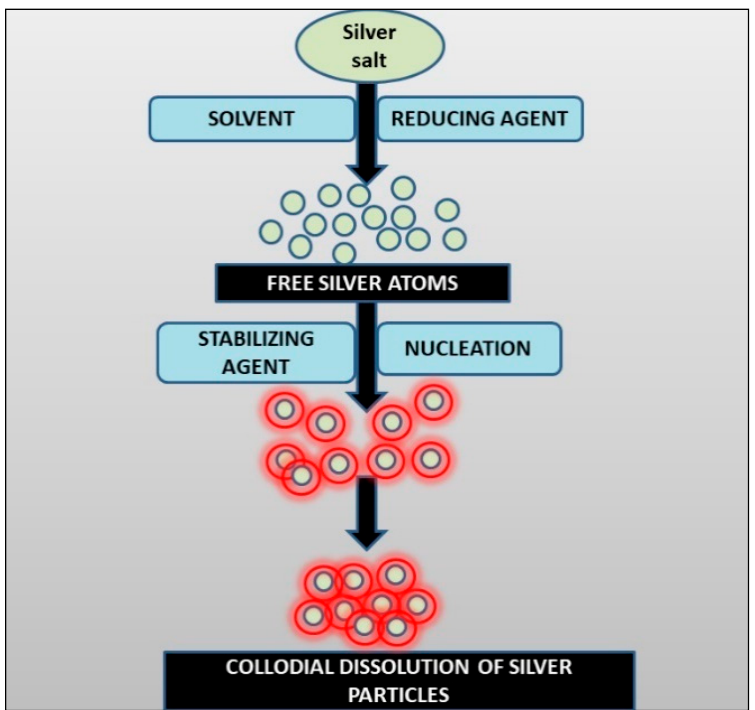
Figure 2. Schematic of Ag-NPs synthesis by the chemical reduction method.